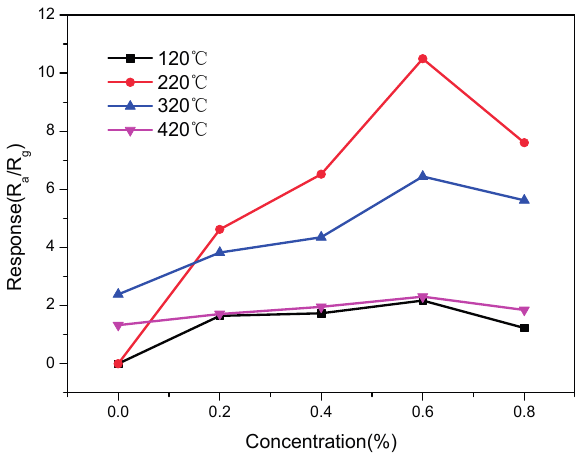
Figure 5. Relationship curves of the response and doping